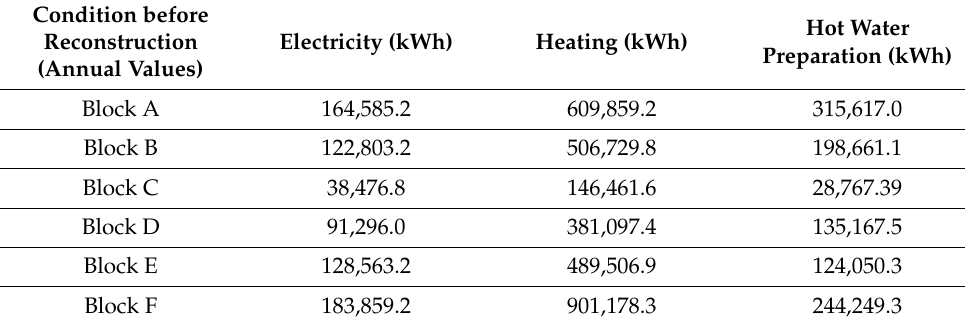
Table 11. Power consumption after the reconstruction.